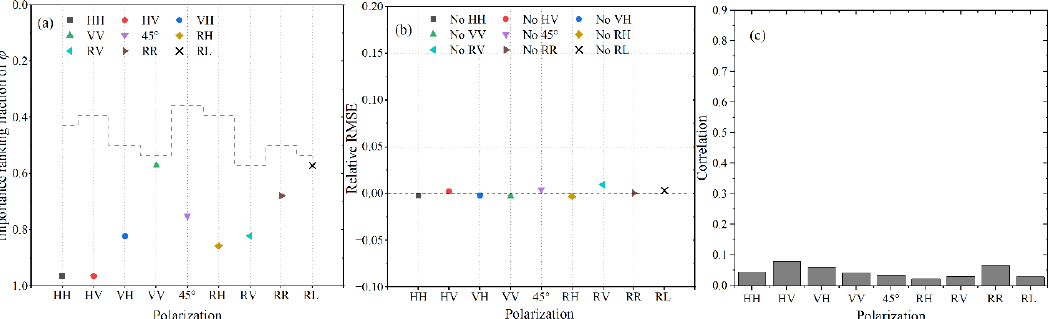
Figure 23. The importance of φ to SWH retrieval from single-polarization models. ( a ) The importance ranking of φ provided by XGBoost models normalized to 0 – 1. The dotted line represents the optimal feature sets under different polarizations. ( b ) The effect of removing φ on the SWH estimation from different polarized models. Different markers in various colors represent φ of different polarizations. ( c ) The correlation between φ and ERA5 SWH under different polarizations.